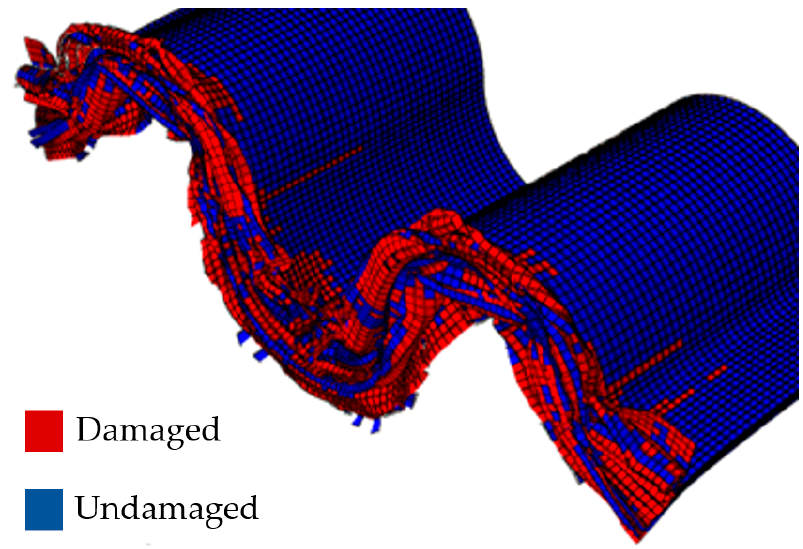
Figure 14. Evaluation of the artificial plug-initiator geometry and the corresponding simulation re- sults compared with the experimentally observed failure modes.